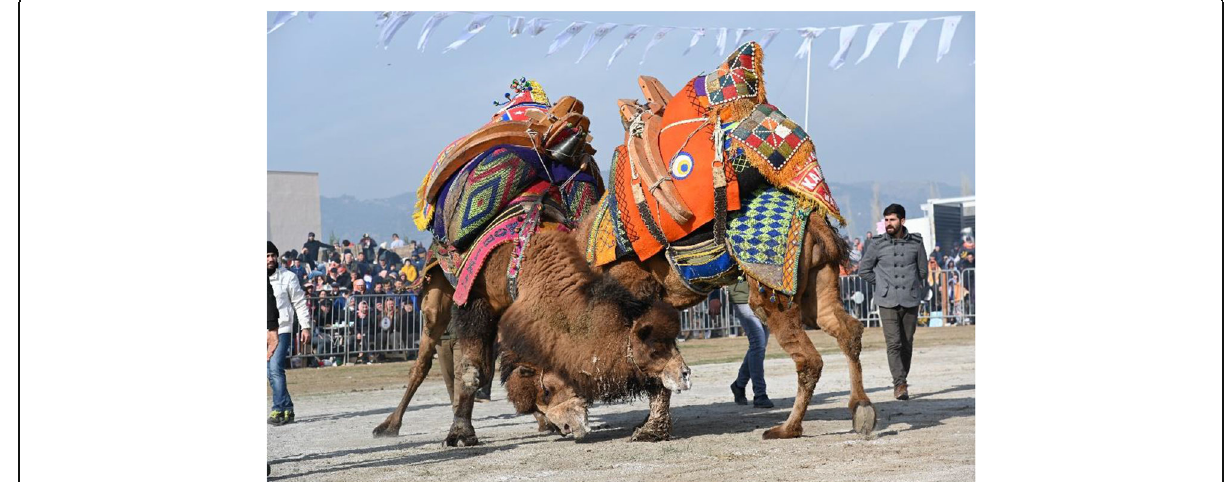
Fig. 8 Camel hybrid at camel wrestling festival, Inçirliova, Turkey (Ph. B.